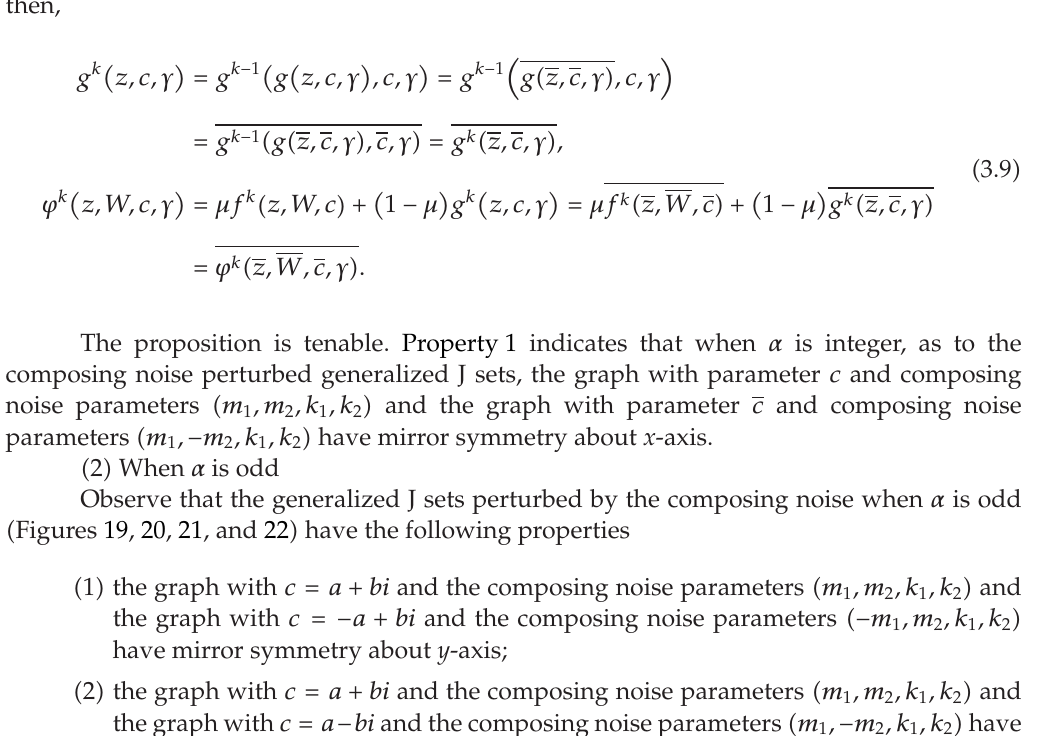
Figure 18: The generalized J sets perturbed by the composing noise when α (cid:6) 4, here Figures (cid:3) a (cid:4) and (cid:3) b (cid:4) are the graphs with c (cid:6) − 0 . 5 (cid:5) 0 . 5 i , Figures (cid:3) c (cid:4) and (cid:3) d (cid:4) are the graphs with c (cid:6) − 0 . 5 − 0 . 5 i .